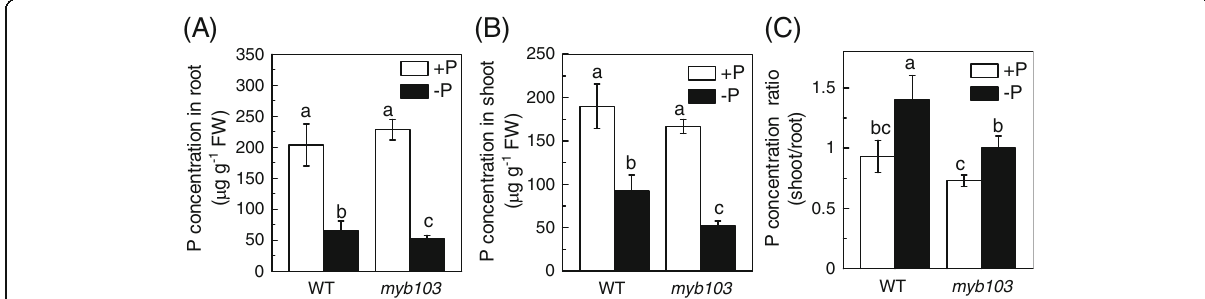
Fig. 3 Disruption of MYB103 affects root-to-shoot P translocation. WT and myb103 seedlings were grown under +P or -P conditions for 7 d, root ( a ) and shoot ( b ) P concentration was measured. The ratio of shoot P concentration to root P concentration ( c ) was calculated. Values are means ± SD, n = 4. Different letters represent a significant difference at P <